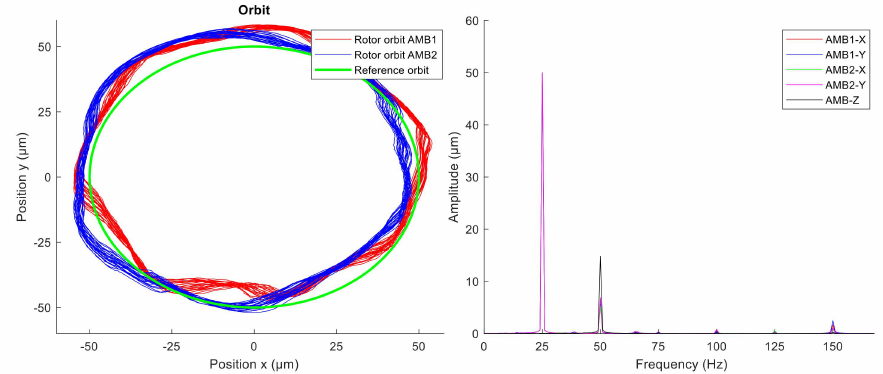
Figure 15. Measured rotor orbits ( left ) and signal amplitude spectra ( right ) without AVC. The second experiment was performed with active vibration compensation. The GNF was used to compensate for the first and the third multiple of the rotor spin speed (1X, 3X). The measured rotor orbit and amplitude spectra are shown in Figure 16. The time interval of the displayed measured data is one